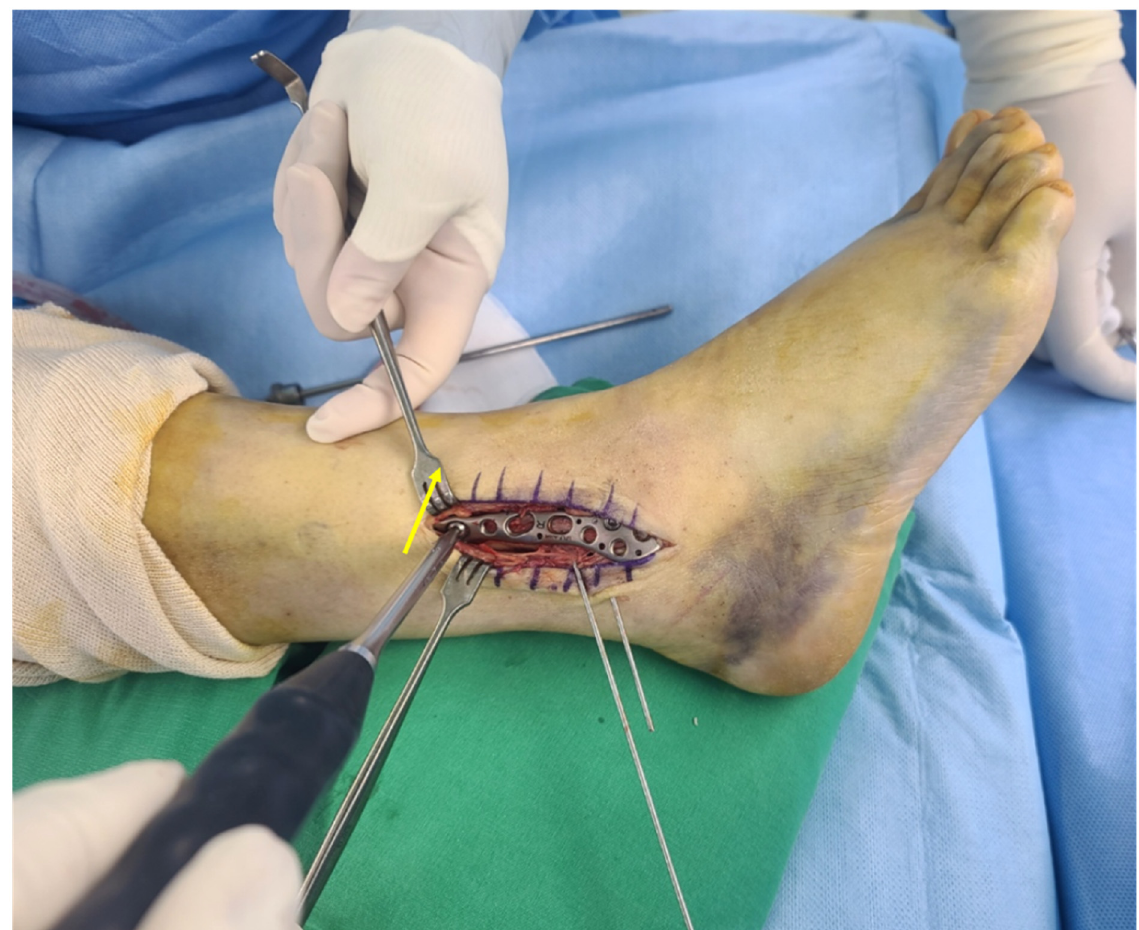
Figure 4. Intraoperative image showing the cortical screw insertion on the proximal part of the fracture. As the proximal portion of the plate is bent posteriorly, posterior to anterior compression force (arrow) can be applied on the fracture site by inserting the cortical screw through the proximal hole, with the equivalent vector applied by lag screw insertion (the ankle is internally rotated on the operative field to facilitate screw insertion).